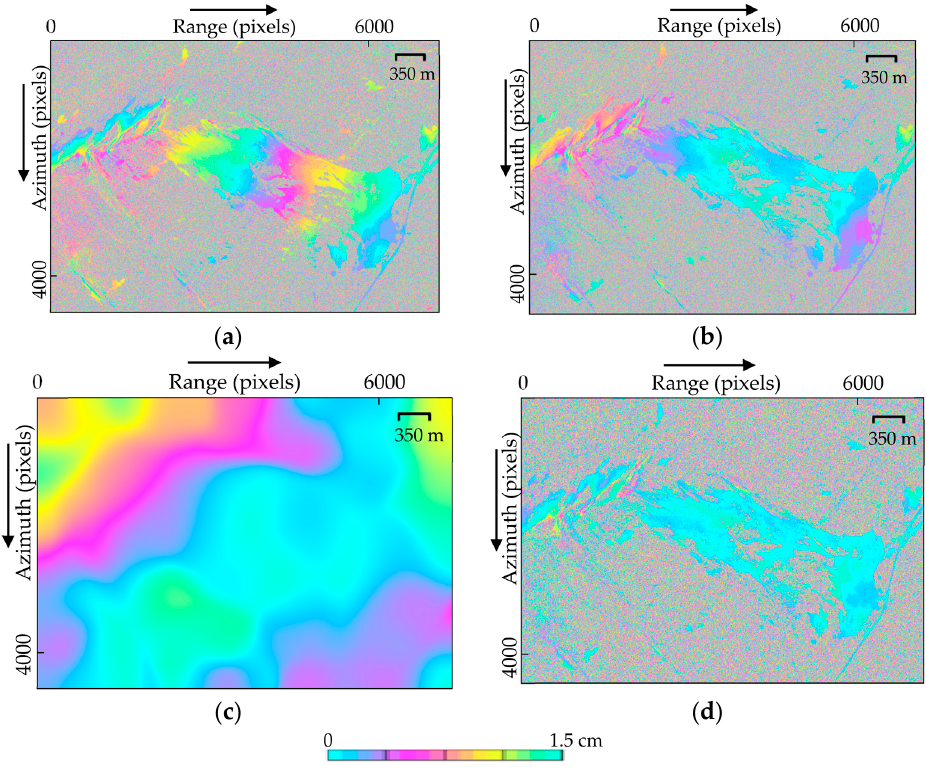
Figure 7. Hope Slide: TSX interferogram (21 June 2015–4 August 2015). ( a ) Original; ( b ) static atmospheric corrected; ( c ) dynamic atmospheric screen; ( d ) static and dynamic atmospheric removed. Table 3. Hope Slide presented interferograms.